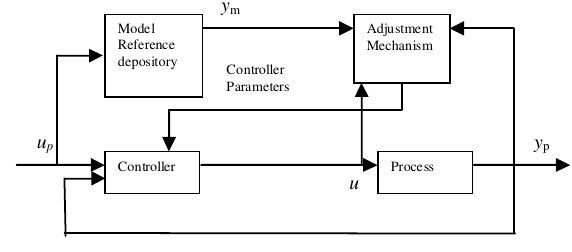
Fig. 4. Model Reference Adaptive Control